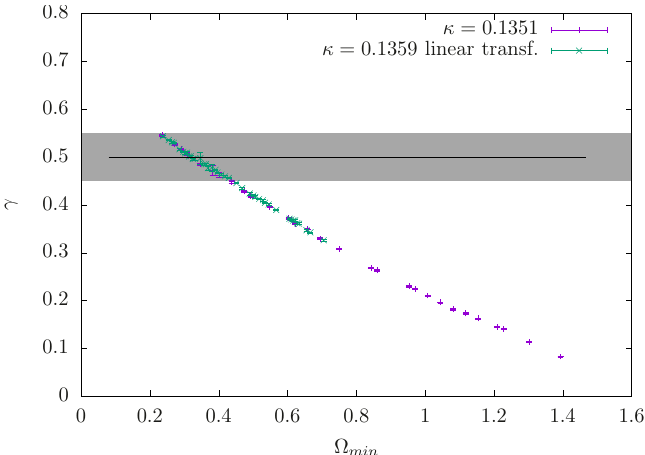
Figure 7 . Fitted value of the mass anomalous dimension for the ensemble at (cid:12) = 1 : 5, (cid:20) = 0 : 1351 (ensemble D), and (cid:20) = 0 : 1359 (ensemble H). (cid:10) min denotes the lower end of the (cid:12)tting interval, while the upper end is (cid:12)xed to (cid:10) min +0 : 07. The (cid:10) min values on the x-axis are rescaled by the linear transformation (cid:10) 0 = 0 : 88(cid:10) min + 0 : 1 for (cid:20) = 0 : 1359 in order to collapse the two ensembles. In the min shaded region we obtain the best (cid:12)ts for both ensembles. Fits with a correlated (cid:31) 2 per degree of freedom larger than 4 are excluded.